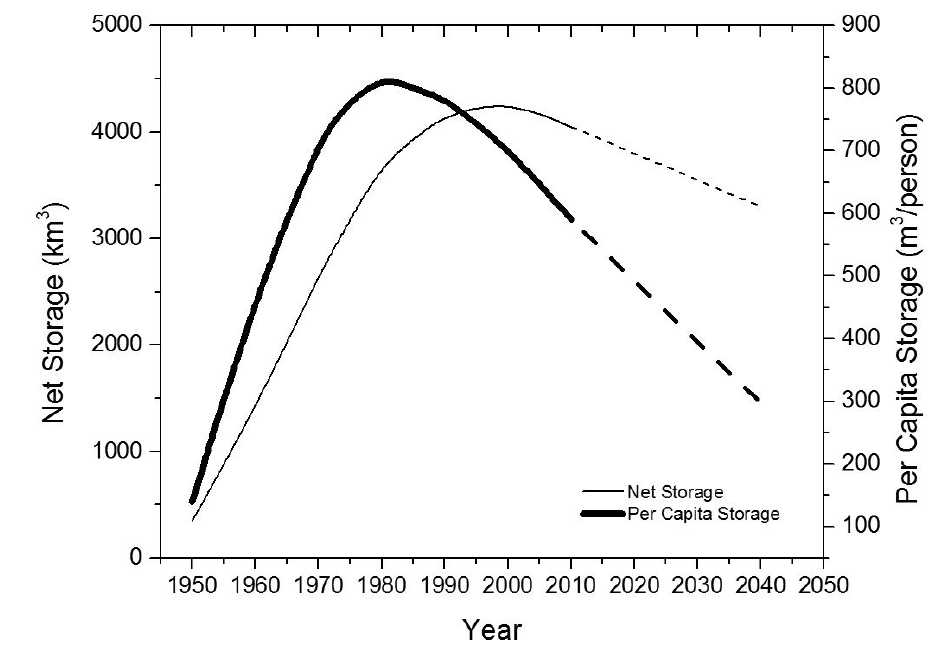
Figure 4. Changes in total and per capita global water storage, projected to 2040, showing losses to sedimentation exceeding new capacity. Source: [7], used by